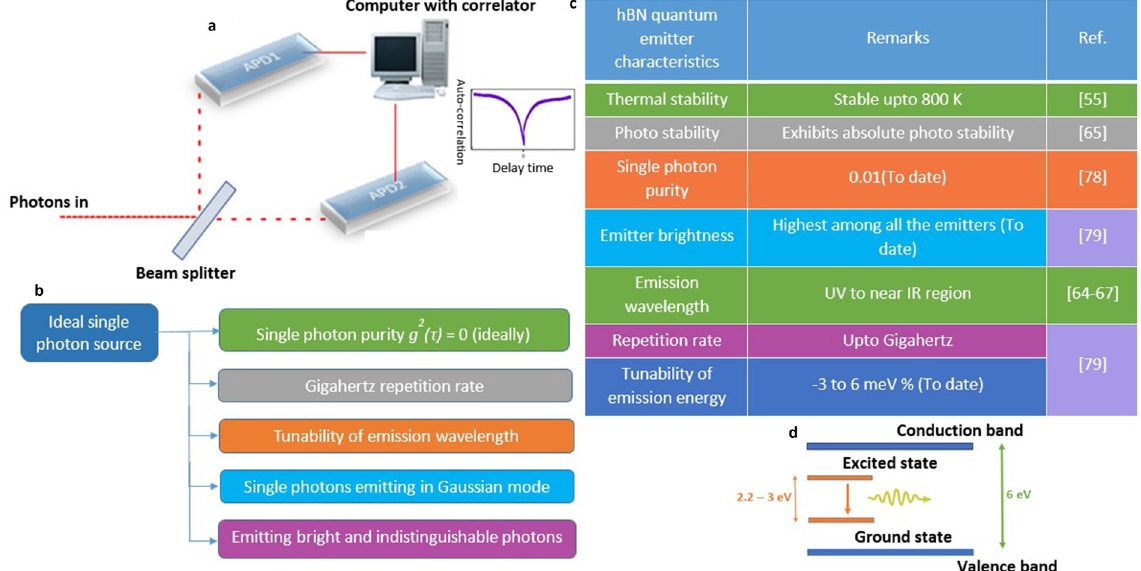
Figure 4. Schematic of HBT interferometer, important features of an ideal single photon source and experimentally observed quantum emitter characteristics, pictographic representation of atomic behaviour of defects within the host bandgap (a) Schematic representation of HBT interferometer working mechanism and resultant second order autocorrelation curve representing characteristics of a single photon emitter. (b) Important features of an ideal single photon source. (c) Experimentally observed some of the quantum emitter characteristics hosts in hBN, in which characteristic stability upto 800 K and single photon purity 0.01 makes a highest record among all the 2D materials (to date). (d) The energy band diagram of an hBN host with ~ 6 eV bandgap. A luminescent point defect in hBN (with energy range ~ 2.2–3 eV) exhibits an artificial atom kind of behaviour with ground and excited